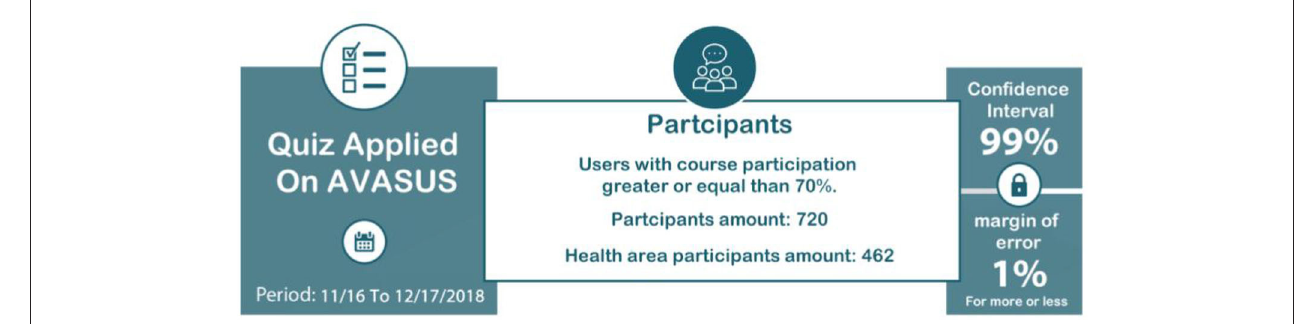
FIGURE 1 | Description of data.